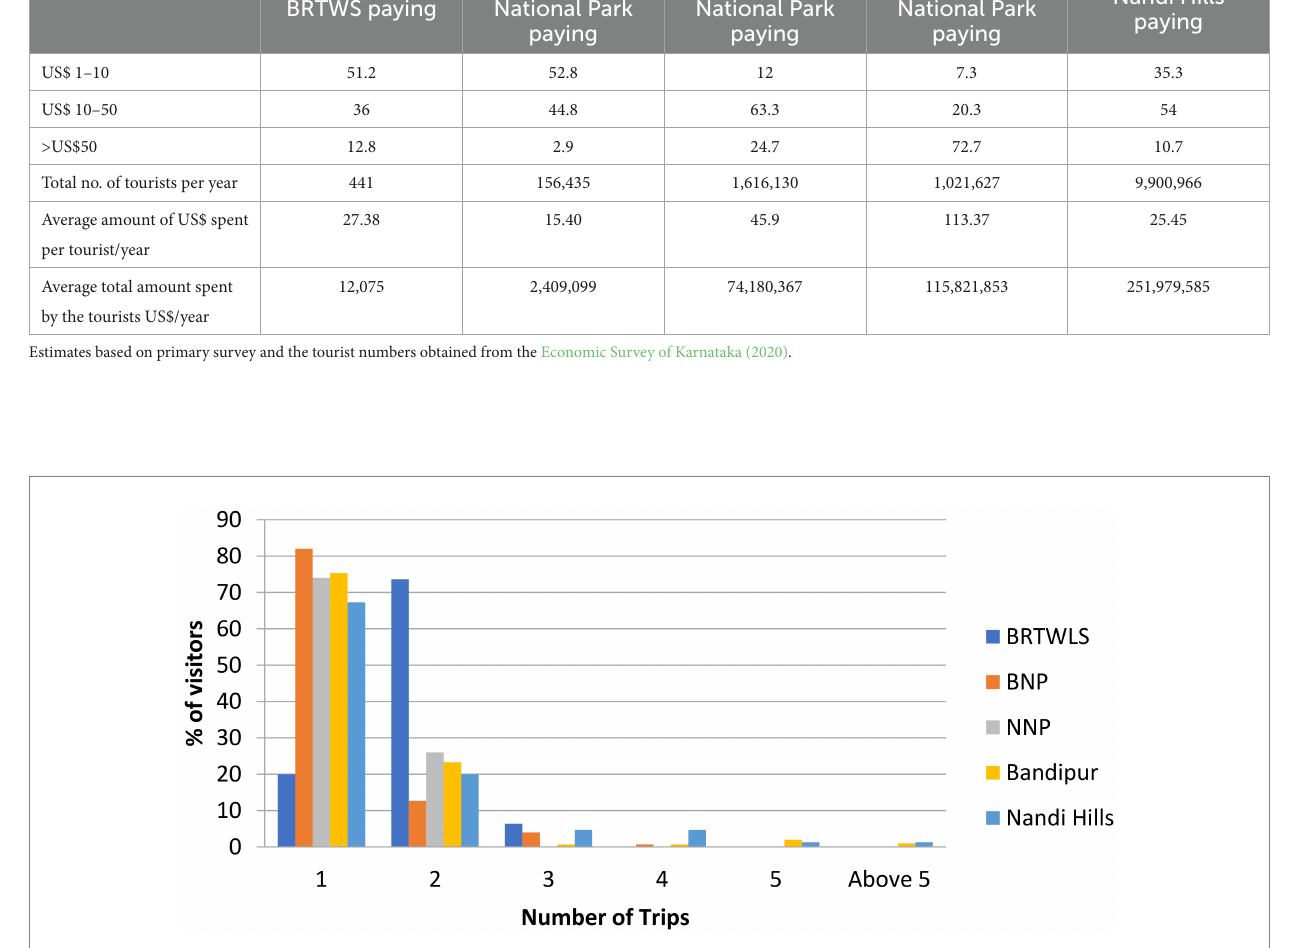
a small percentage twice; BRTWLS is the only place that is visited twice by >70% of the tourists.